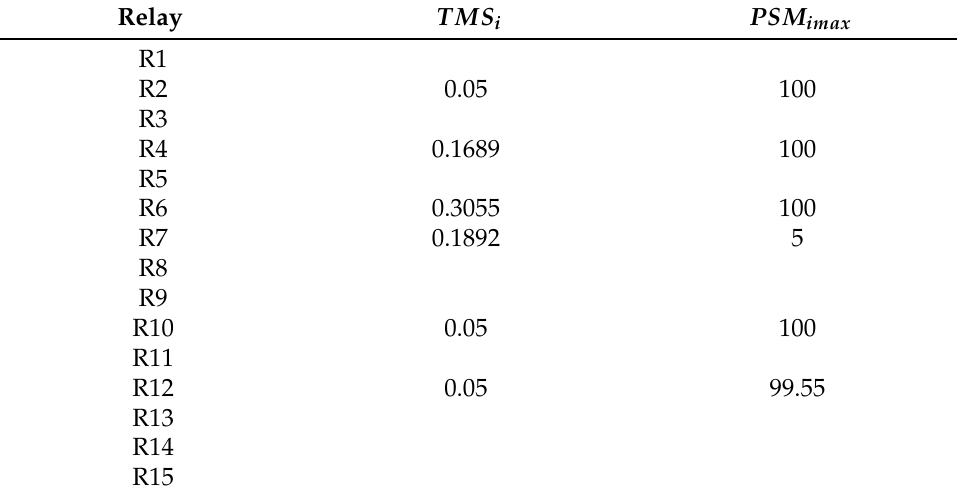
Table 3. Coordination parameters for Scenario 1.